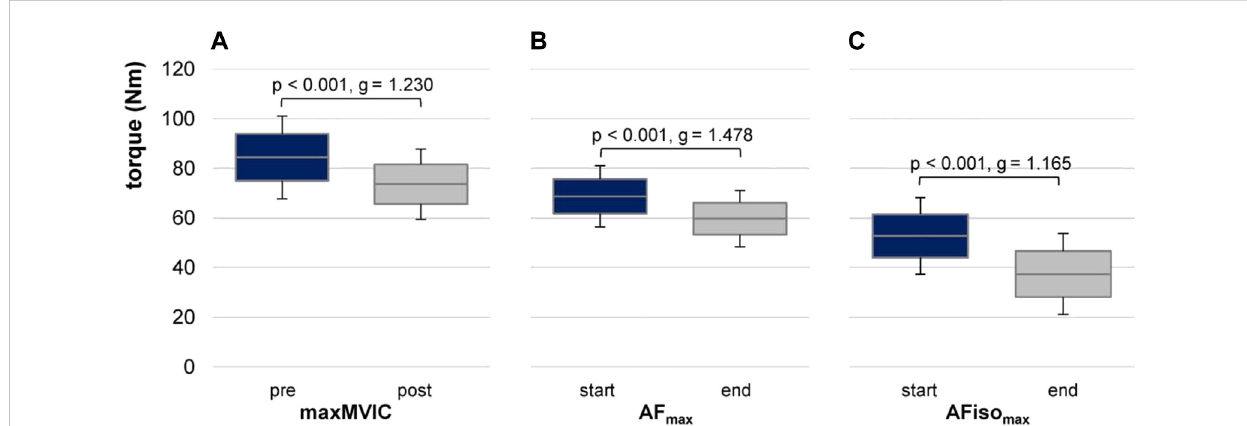
FIGURE 3 Maximal torques at pre/post and start/end of 30 AF trials. Arithmetic means, standard deviations (error bars), and 95% con fi dence intervals (CIs) are depictedformaximalvaluesof (A) MVICbefore(pre)andafter(post)AFtrials(maxMVIC), (B) maximalAdaptiveForce(AF max ),and (C) maximalisometricAF (AFiso max ) at start and end. p -values and effect sizes of Hedges ’ g are given for pairwise comparisons.